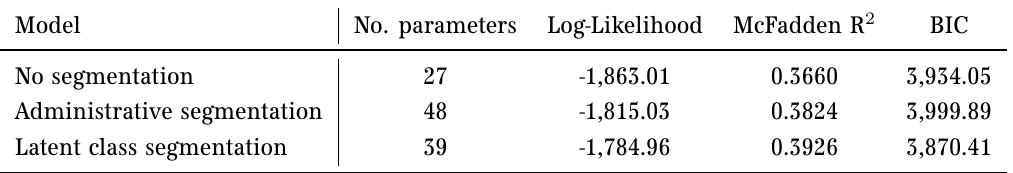
Table 8: Comparison of goodness of fit statistics for discrete shipment size choice models with no segmentation, administrative segmentation and 5 latent